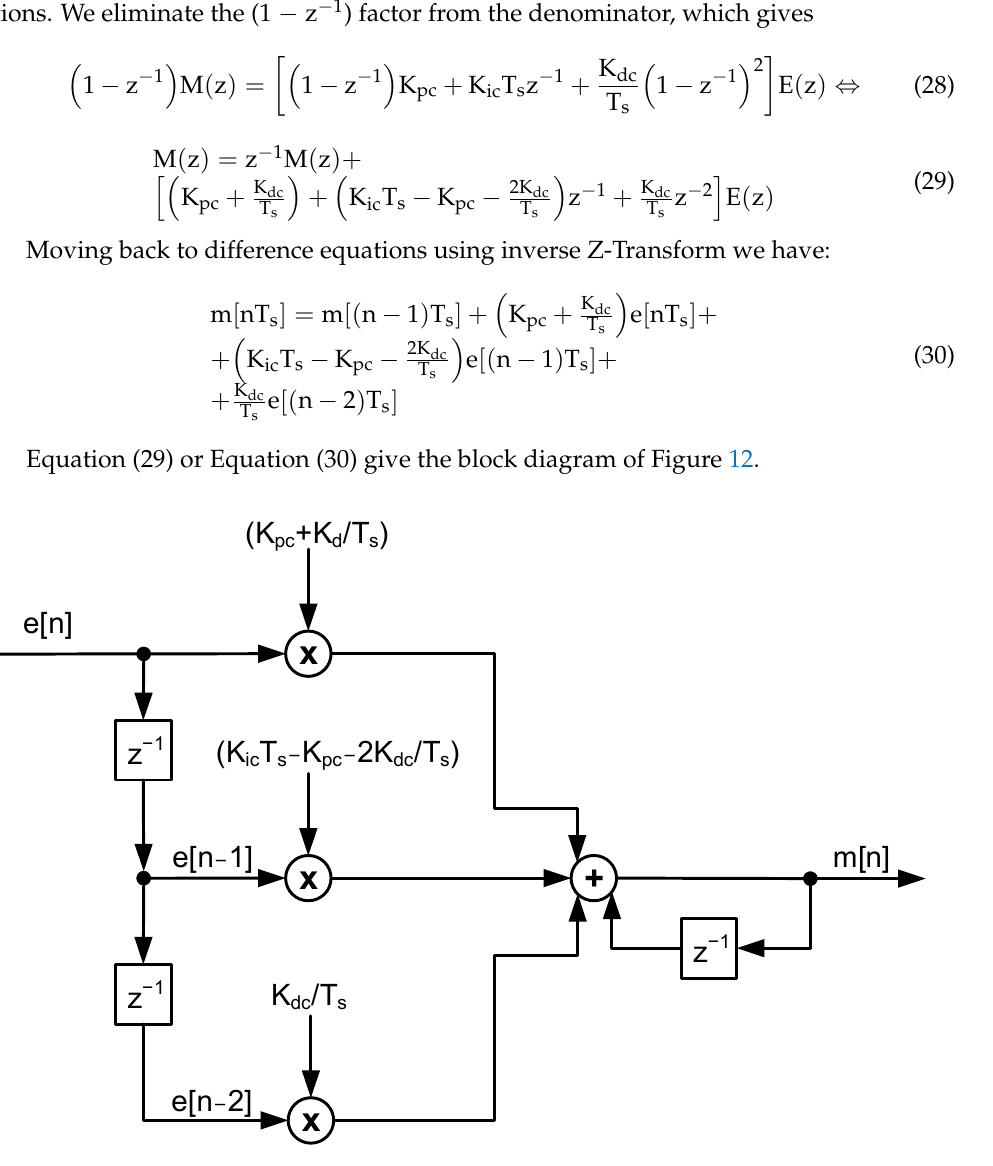
Figure 12. Block diagram for digital PID implementation.